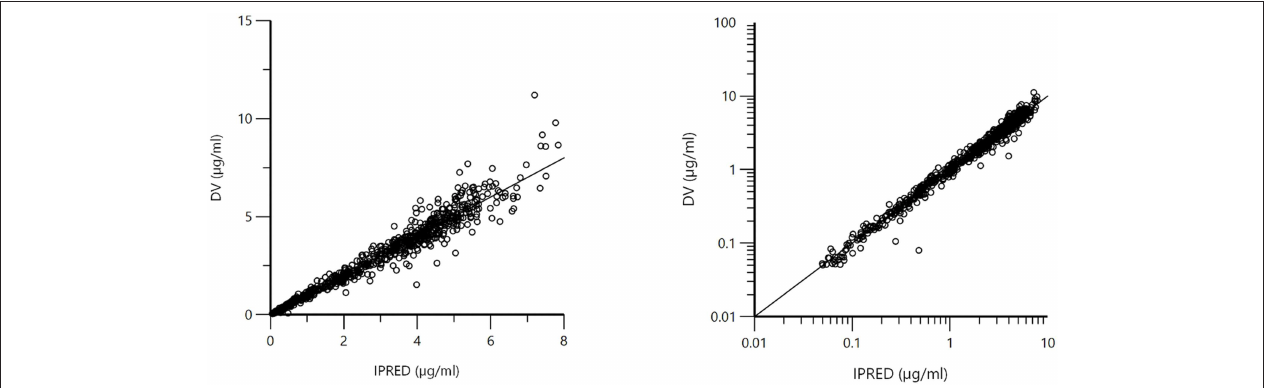
FIGURE 3 | Plot of the dependent variable (DV) i.e., observed plasma florfenicol concentration ( µ g/ml) vs. individual predicted plasma florfenicol values (IPRED). Individual prediction was obtained by setting random effects to the “ post-hoc ” or empirical Bayesian estimate of the random effects for the individual from which the DV observation was made. Thus, the plots illustrate observed vs. fitted values of the model function. Ideally they should fall close to the line of unity y = x. Arithmetic scale (left) and logarithmic scale (right) . For both the arithmetic and logarithmic scales, data were evenly distributed about the line of identity, indicating no major bias in the population component of the model.